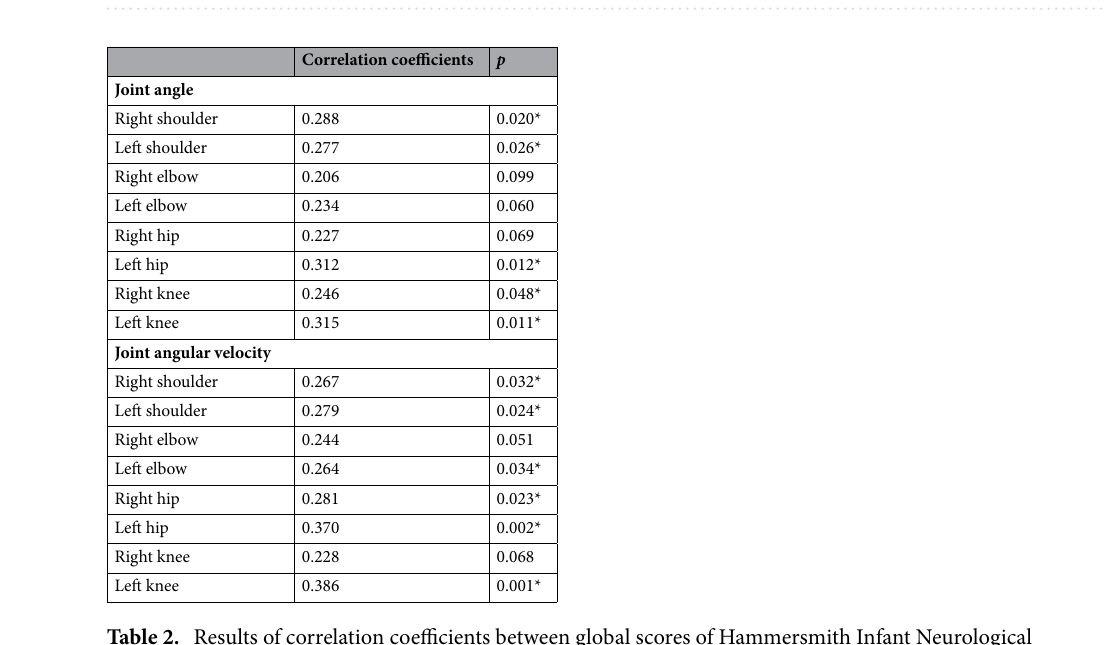
Figure 2. Illustrations of joint angles and joint angular velocities at the bilateral shoulders, elbows, hips, and knees in two preterm infants with Hammersmith Infant Neurological Examination (HINE) ≥ 60 ( A , B ) and those with HINE < 60 ( C , D ).